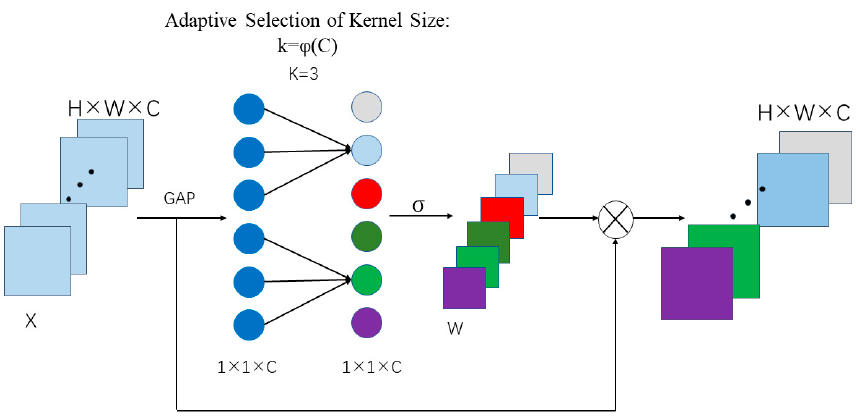
Figure 4. ECA module structure.